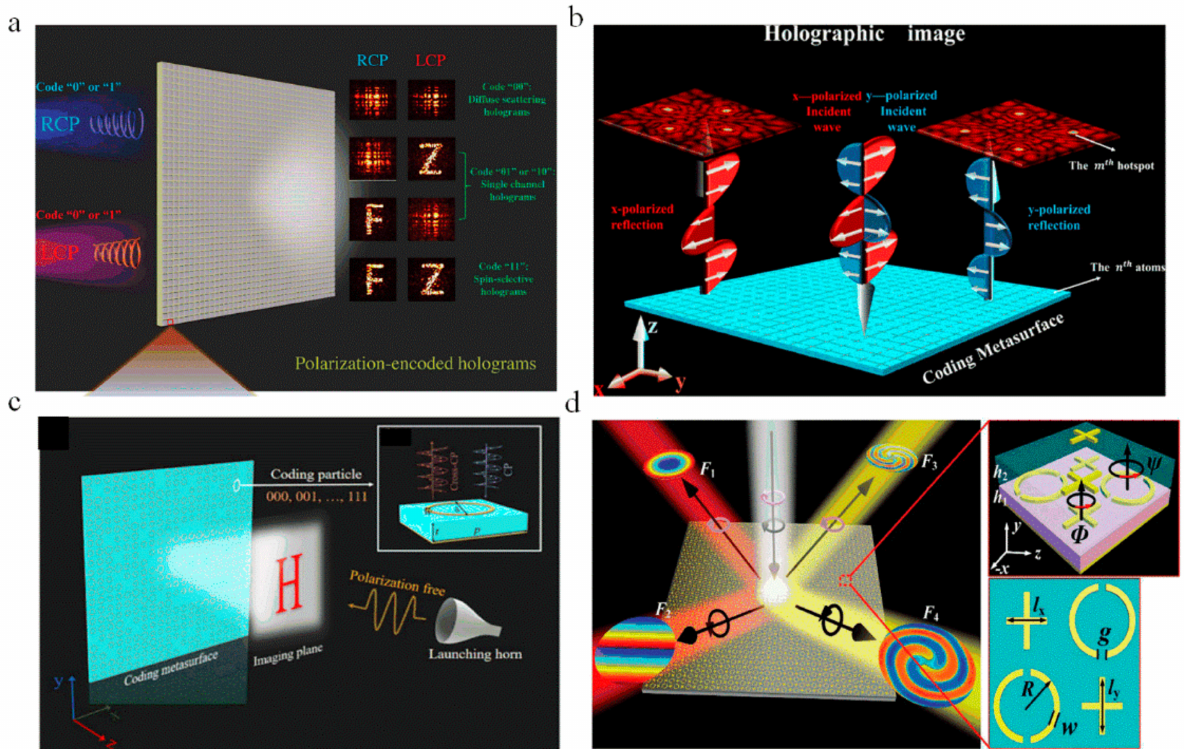
Figure 6. Polarization-multiplexed metasurface holograms. ( a ) A spin-selective transmission polarization-encoded holo- gram. Reprinted with permission from ref. [111]. Copyright 2020 John Wiley and Sons. ( b ) A co-polarization reflection coded hologram under the incidence of x -and y -polarized plane waves. Reprinted with permission from ref. [112]. Copyright 2021 AIP Publishing. ( c ) A helicity-switched meta-hologram that reflects the letter H under the incidence of a circularly polarized wave. Reprinted with permission from ref. [113]. Copyright 2020 Optical Society of America. ( d ) Illustration of the quad-port meta-plexer using the proposed mode- and spin-decoupled meta-atom. Reprinted with permission from ref. [114]. Copyright 2019 John Wiley and